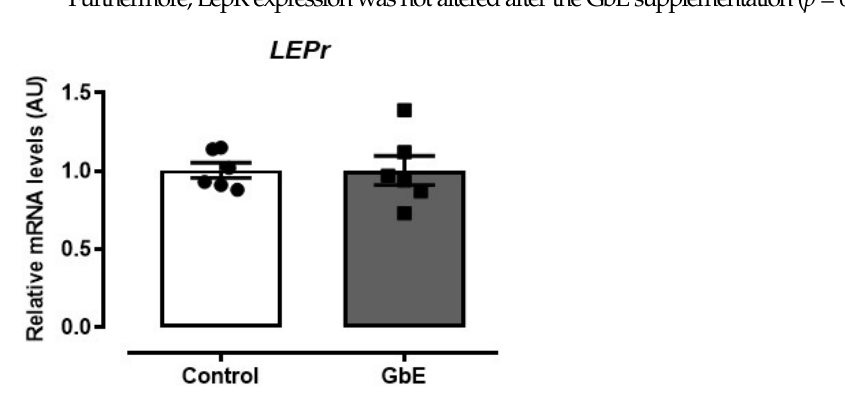
Figure 2. Relative mRNA levels of the serotonin receptors and serotonin transporter: 5-HT1A ( a ), 5- HT1B ( b ), 5-HT2C ( c ), and 5HTT ( d ) of Control ( n = 5–6) and Ginkgo biloba (GbE; n = 5–6) groups analyzed by RT-qPCR. * p < 0.05.